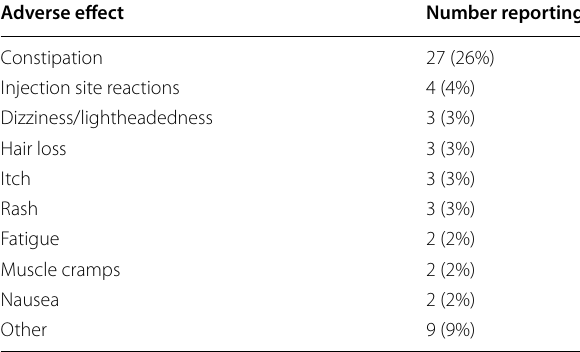
Table 3 Adverse effects reported during the 3-month treatment period. Some patients experienced multiple adverse